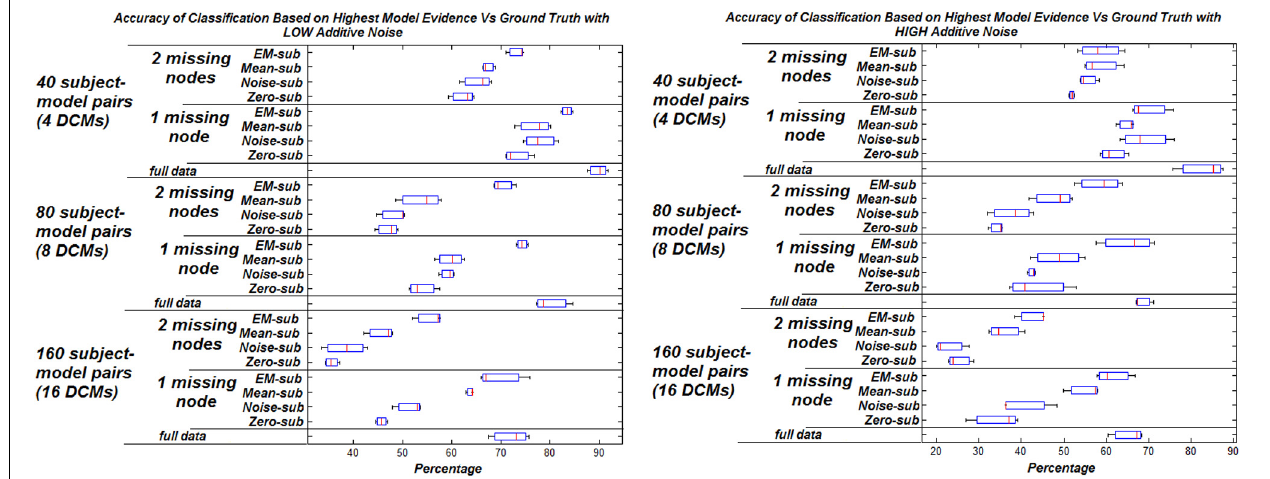
FIGURE 2 | Accuracy of classification based on highest model evidence vs. ground truth with varying levels of noise. Zero missing nodes (full data) is the baseline for comparison. Box plots show the bootstrap variance of classification